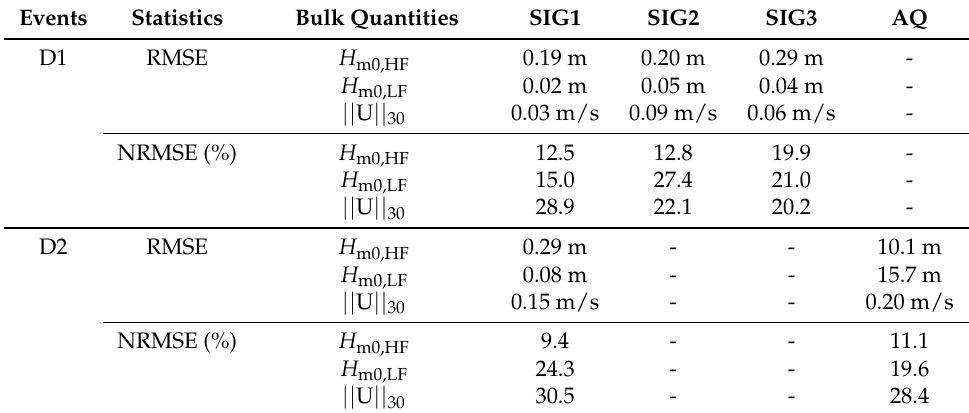
Table 1. Root-mean-squared error (RMSE) and its normalized value (NRMSE) computed for each event and at each instrument